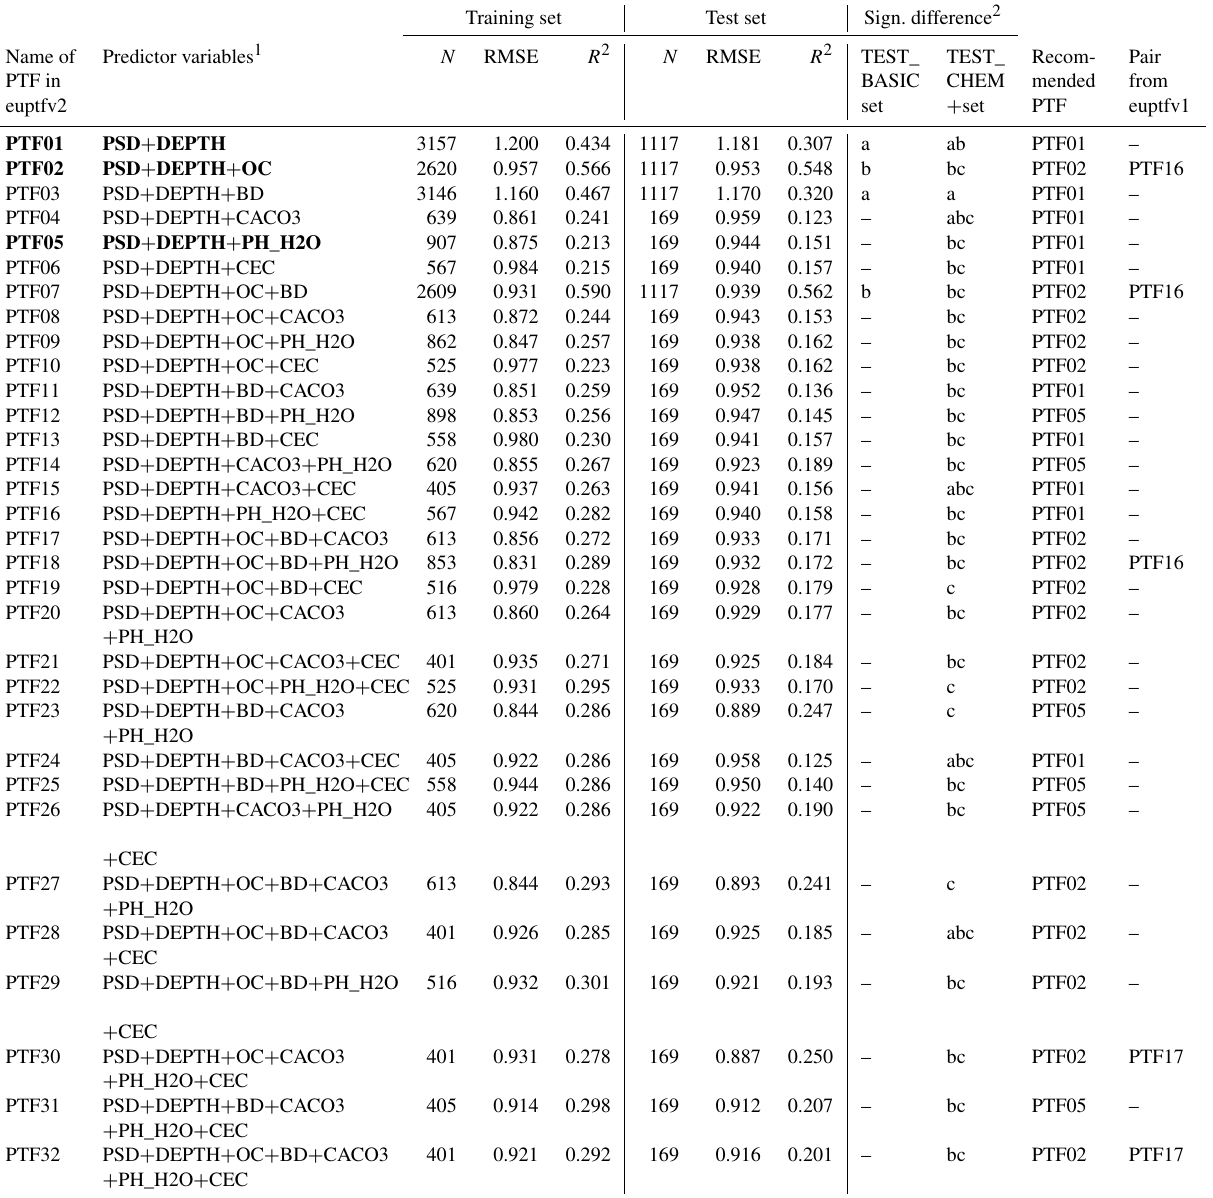
Table 6. Performance of pedotransfer functions (PTFs) by input combination on training and test datasets to predict saturated hydraulic con- ductivity (KS). N : number of samples, RMSE: root mean square error (log 10 (cmd − 1 )) , and R 2 : determination coefficient, TEST_BASIC: samples with measured PSD, DEPTH, OC and BD; TEST_CHEM + : samples with measured PSD, DEPTH, OC, BD, CACO3, PH_H2O and CEC. Recommended PTFs are highlighted in